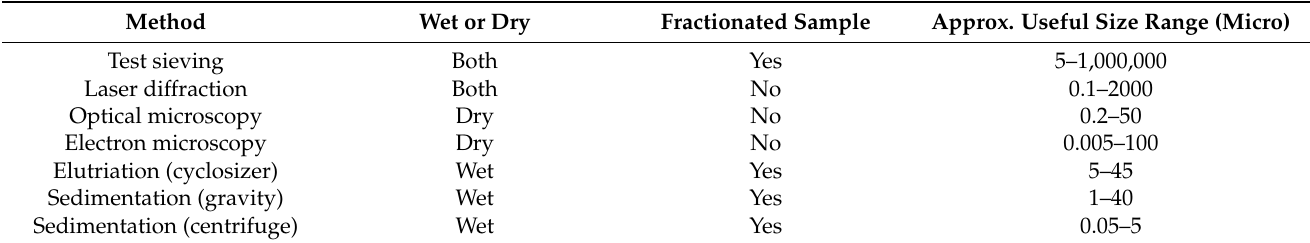
Table 3. Alternative methods of particle size analysis [7].